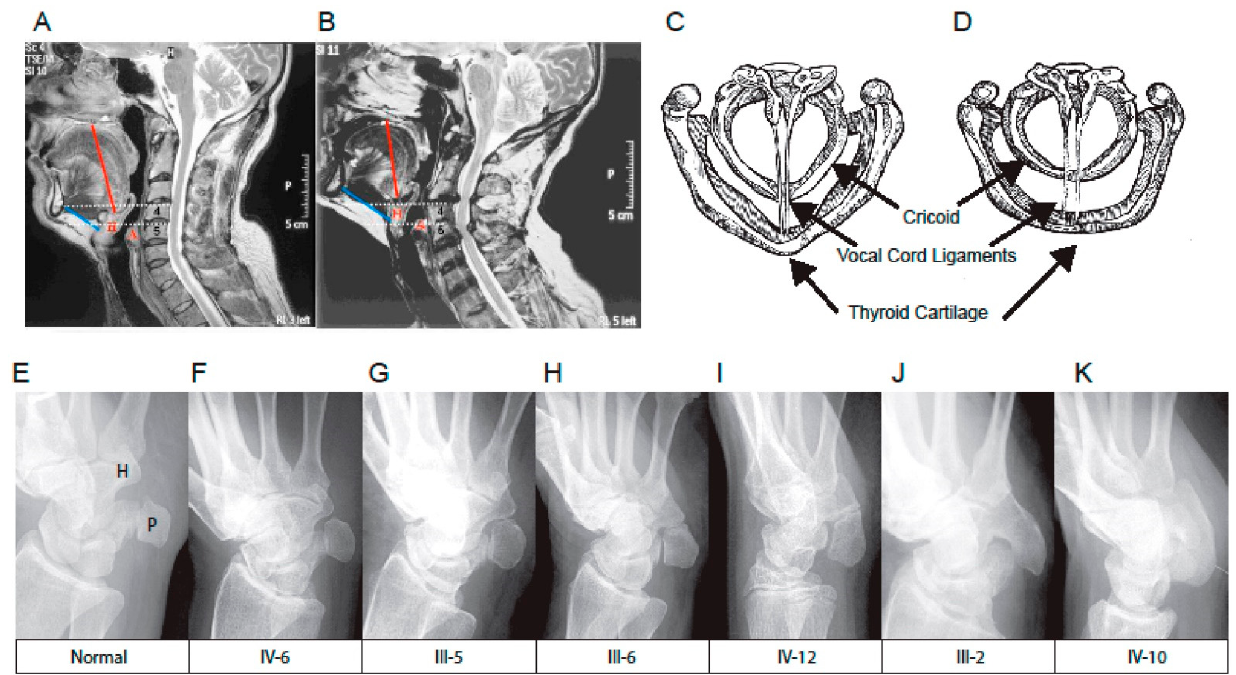
Figure 4. Retrograde malformation of the larynx and wrist . MRI analyses of the head and neck ( A ) Unaffected male from the family of matching age with a ( B ) Severely speech impaired male member of the family (III-6) with malformation of the supra-laryngeal vocal apparatus including superior (infantile/retrograde) positioning of the tongue (red line), hyoid and laryngeal cartilages—relative to the spinal axis (white dotted lines) [3–6] and increased length of the mandible (blue line). Schematic plan view of the laryngeal cartilages from endoscopic analysis for ( C ) Unaffected control and ( D ) Speech impaired male (III-6) with shortened vocal cords of altered composition and structure that failed to oppose during quiet breathing or to vibrate normally for speech or deep inspiration [14,20]. Radiological images of the wrist indicate bilateral osseous remodelling and retrograde elongation of the pisiform to varying degrees in all affected family members tested that were near identical bilaterally [8]. ( E – K ) Lateral images of pisiform from affected family members aligned in graded series of elongation, Arytenoid (A), Hyoid (H). Pisiform (P), Lunate (L), Ulna (U).